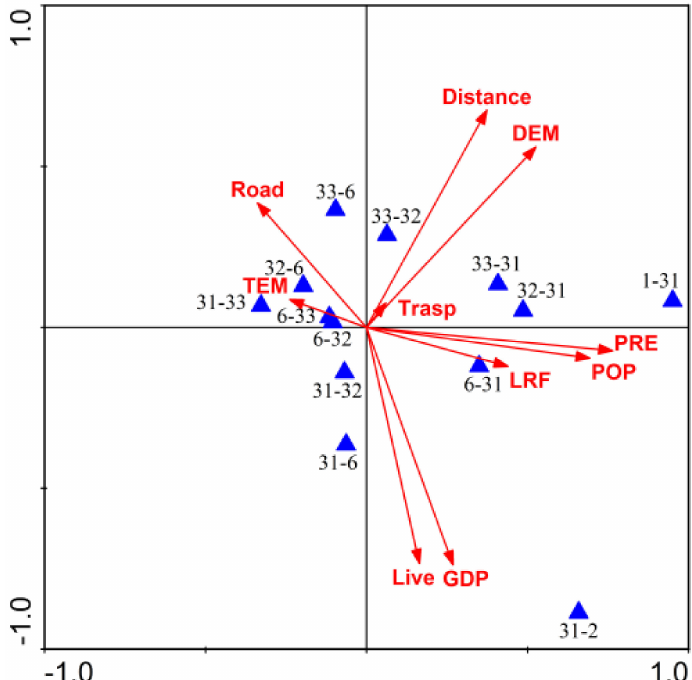
Figure 9. CCA biplot of land-use change types and environmental